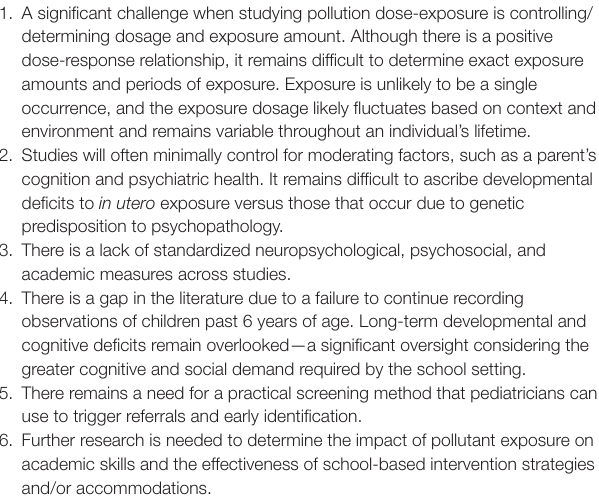
tABLe 3 | Early life pollutant exposure: research limitations and challenges.